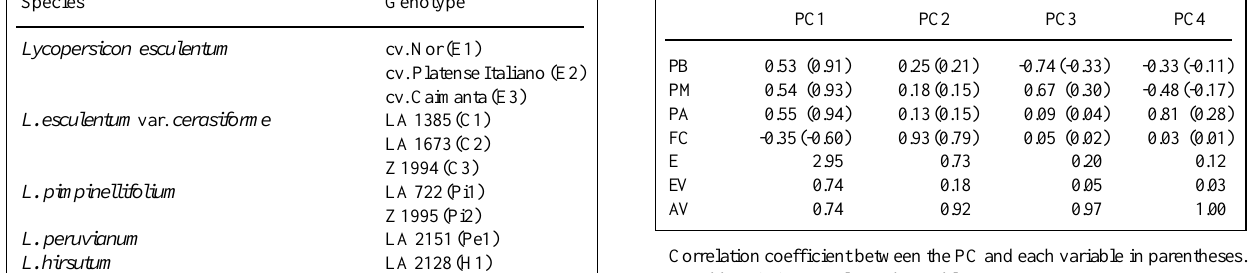
Table III - Principal components (PC), eigenvalues (E) and proportions of explained variances (EV) and accumulated variances (AV) for the non- regenerated plants (NP) of different Lycopersicon species.